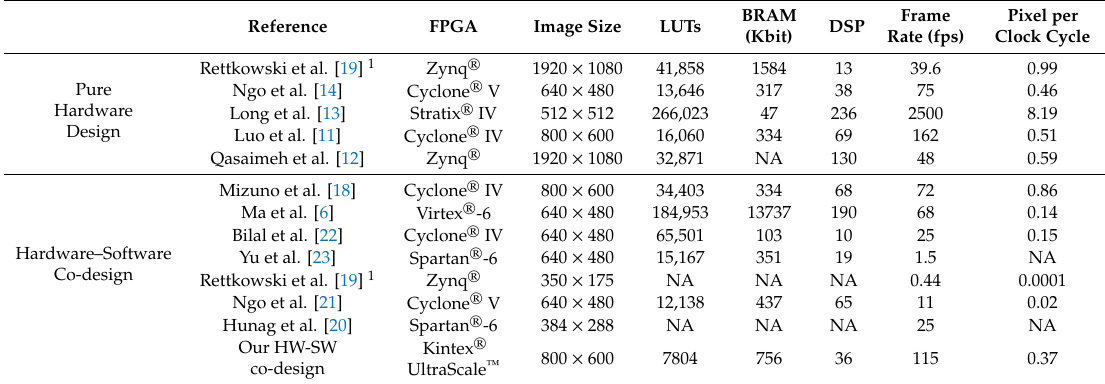
Table 3. Comparison with other